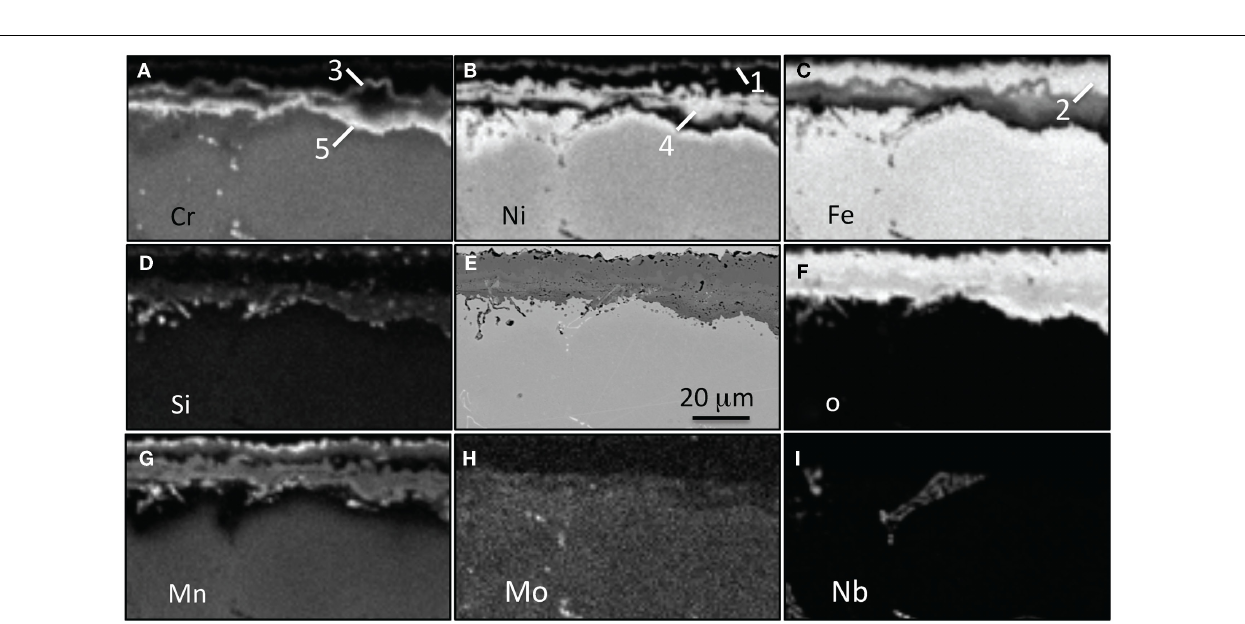
FIGURE 13 | EPMA mapping for alloy CF8CWCu-2 exposed for 1000h in air +++ 10% H 2 O at 800°C, (A) Cr, (B) Ni, (C) Fe, (D) Si, (E) SEM picture, (F) O, (G) Mn, (H) Mo, and (I) Nb . Five different oxide scales are labels.